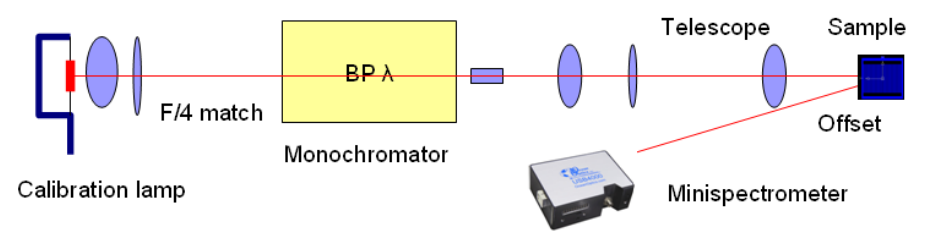
Figure 6. Spectroscopic measurement of efficiency with a custom tunable calibration